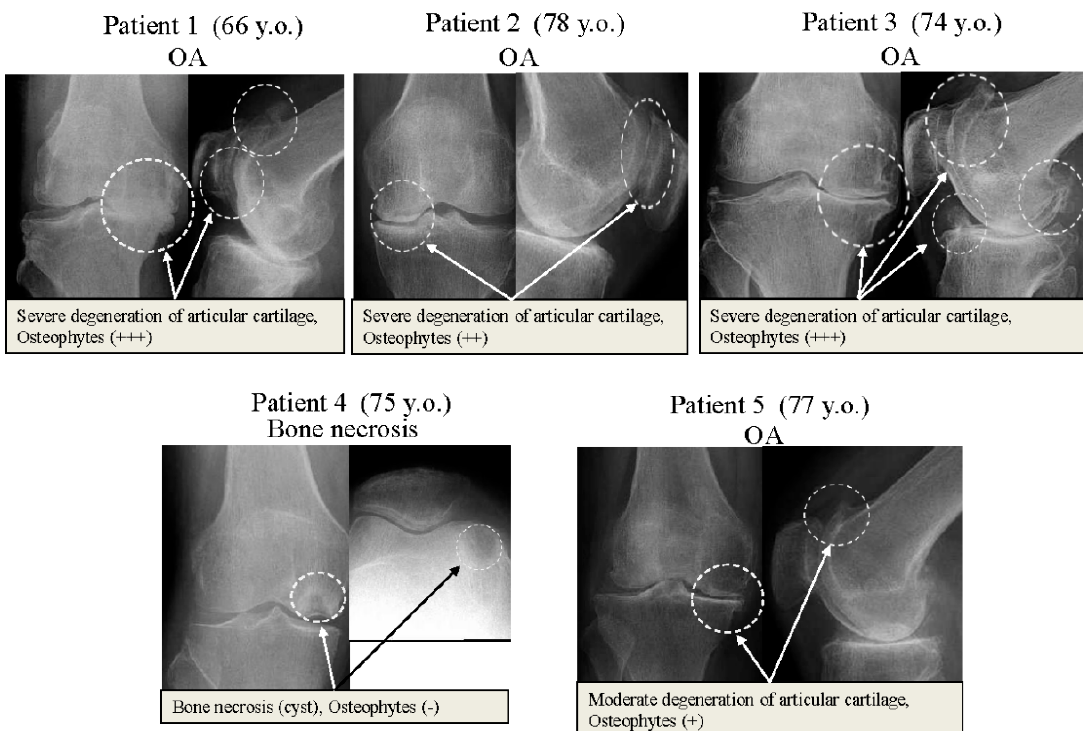
Figure 1. X-ray images of knee joints of donor patients. Patient 1; female, 66 years of age, Patient 2; female, 78 years of age, Patient 3; male, 74 years of age, Patient 4; female, 75 years of age, Patient 5; female, 77 years of age. Patient 1, 2, 3 had severe knee OA with severe cartilage degeneration and osteophyte formation. Patient 4 had idiopathic osteonecrosis of femoral condyle. Patient 5 had moderate knee OA with cartilage degeneration and osteophyte formation. OA; osteoarthritis, y.o.; years old. Table 1. The clinical characteristics of patients.